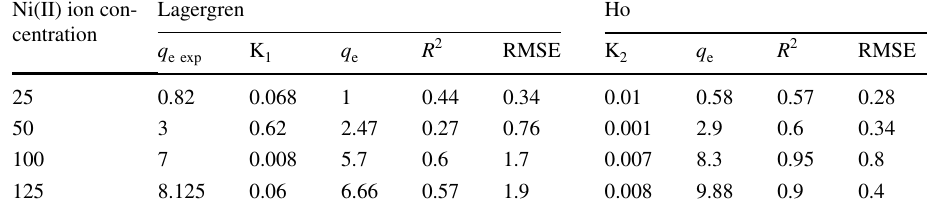
Ni(II) ion con- centration